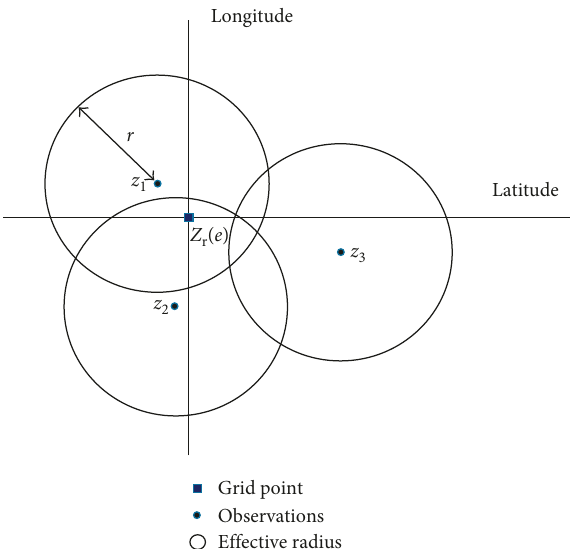
Figure 2: Calculation of the Z point e in the Cressman method. Only observations of stations located within the effective radius r are used. In this example, z and z are used to calculate Z r ( e ) , but z 2